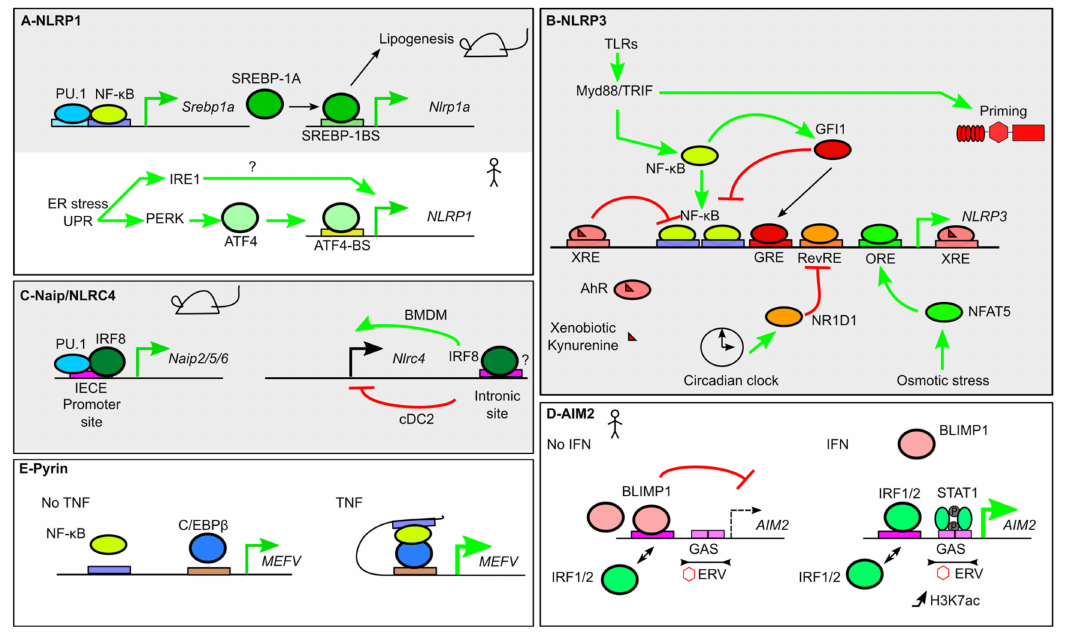
Figure 2. Transcriptional regulation of inflammasome sensors. ( A ) In mice (gray background), Nlrp1a expression is indirectly induced by Nuclear factor κ B (NF- κ B), which controls Srebp1a expression. SREBP1A couples Nlrp1a expression and lipogenesis. In humans, NLRP1 expression is induced by ER stress and the Unfolded protein response (UPR) and two of its e ff ectors, Inositol-requiring enzyme 1 (IRE1) and PKR-like ER protein kinase (PERK). PERK induces Activating Transcription Factor 4 (ATF4) expression that directly upregulates NLRP1 expression. ( B ) NLRP3 expression is under the control of numerous TFs. NF- κ B activation downstream of Toll-like receptors (TLRs) induces NLRP3 expression, while NLRP3 inflammasome priming is independent on transcription. GFI1 negatively regulates NLRP3 expression. GFI1 expression is inducible by NF- κ B, thus creating a negative feedback loop. Xenobiotics and anti-inflammatory metabolites promote Aryl hydrocarbon receptor (AhR) binding to Xenobiotic Response Elements (XRE) that blocks NF- κ B-mediated NLRP3 induction. Similarly, NLRP3 promoter integrates signals from the circadian clock regulator Nuclear receptor subfamily 1 group d member 1 (NR1D1) and from Nuclear factor of activated T cells 5 (NFAT5), which binds to an Osmotic Response Element (ORE), following osmotic stress. ( C ) Several Naip are regulated at steady state by Interferon Regulatory Factor 8 (IRF8), which binds Ets-Interferon Regulatory Factors (IRF) composite Element (EICE), together with PU.1. Binding of IRF8 in the intronic region of Nlrc4 controls positively or negatively Nlrc4 expression in bone marrow-derived macrophages (BMDM) and type 2 conventional dendritic cells (cDC2), respectively. ( D ) At steady state (left panel) AIM2 expression is repressed due to B lymphocyte-induced maturation protein-1 (BLIMP1) binding to an IRF / BLIMP1 composite site. In the presence of IFN- γ , IRF1 / 2 displace BLIMP1. Furthermore, Signal Transducer and Activator of Transcription 1 (STAT1) binding to GAS triggers AIM2 expression, which correlates with a local increase in H3K7 acetylation (H3K7ac). The tandem GAS sites are present in an endogenous retrovirus sequence (ERV). ( E ) Pyrin encoded by the MEFV gene is under the regulation of NF- κ B. In the presence of Tumor necrosis factor (TNF), a chromatin loop favors NF- κ B and CCAAT / enhancer binding protein β (C / EBP β ) interaction to upregulate MEFV